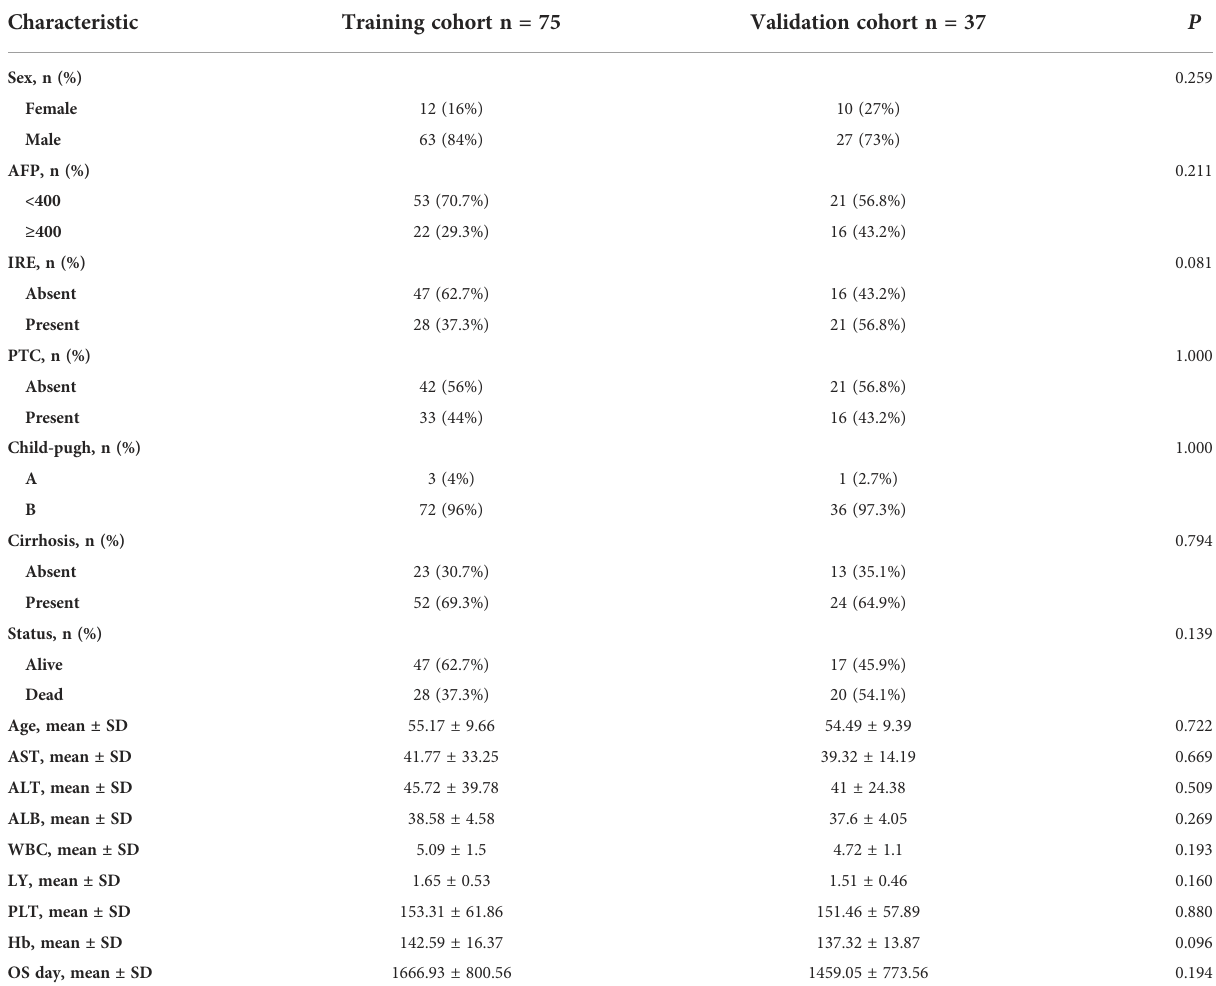
TABLE 1 Baseline patient data in the two